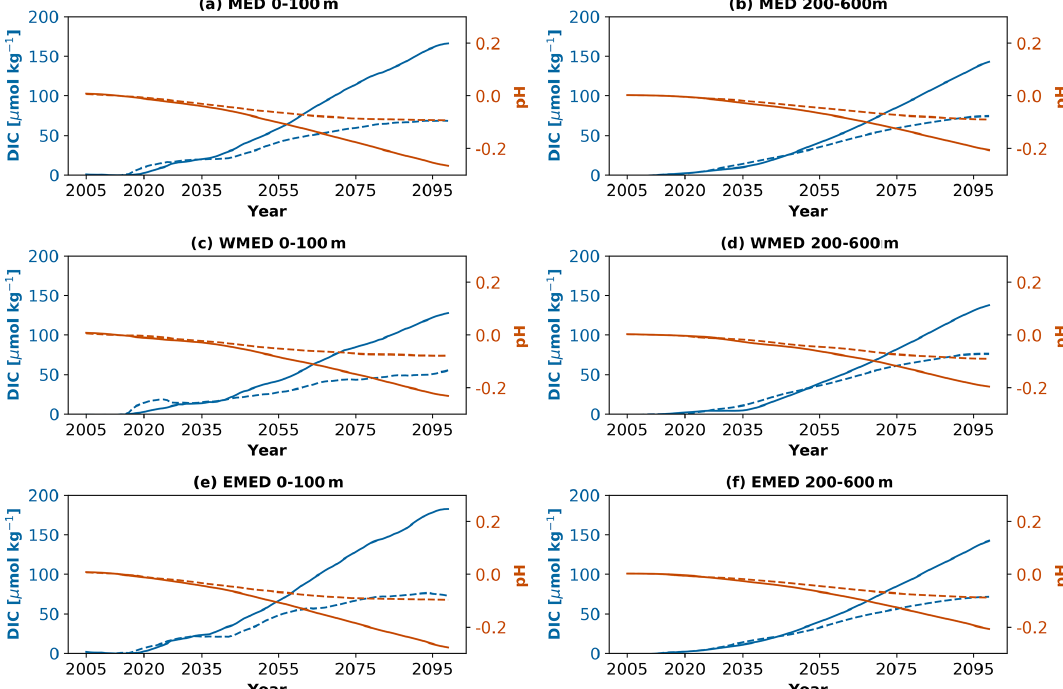
Figure 15. As Fig. 14, but for dissolved inorganic carbon (blue, in µmolkg − 1 ) and pH (dark orange).